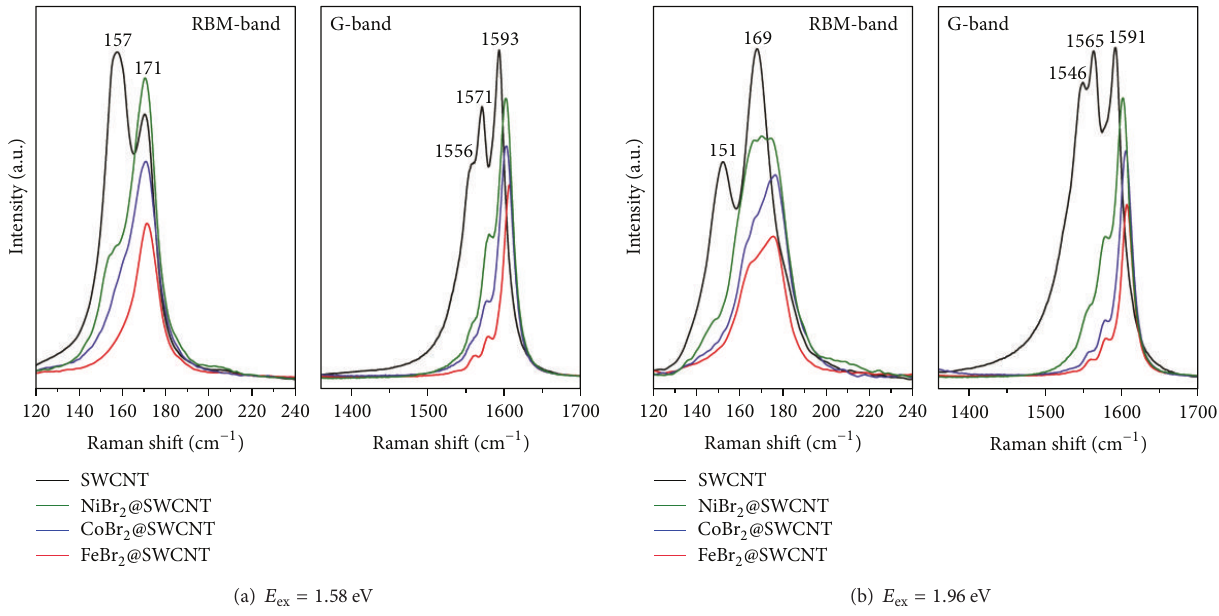
Figure 1: The RBM- and G-bands of the Raman spectra of the pristine SWCNTs, NiBr 2 @SWCNT, CoBr 2 @SWCNT, and FeBr 2 @SWCNT samples acquired at laser energies of 1.58 eV (a) and 1.96eV